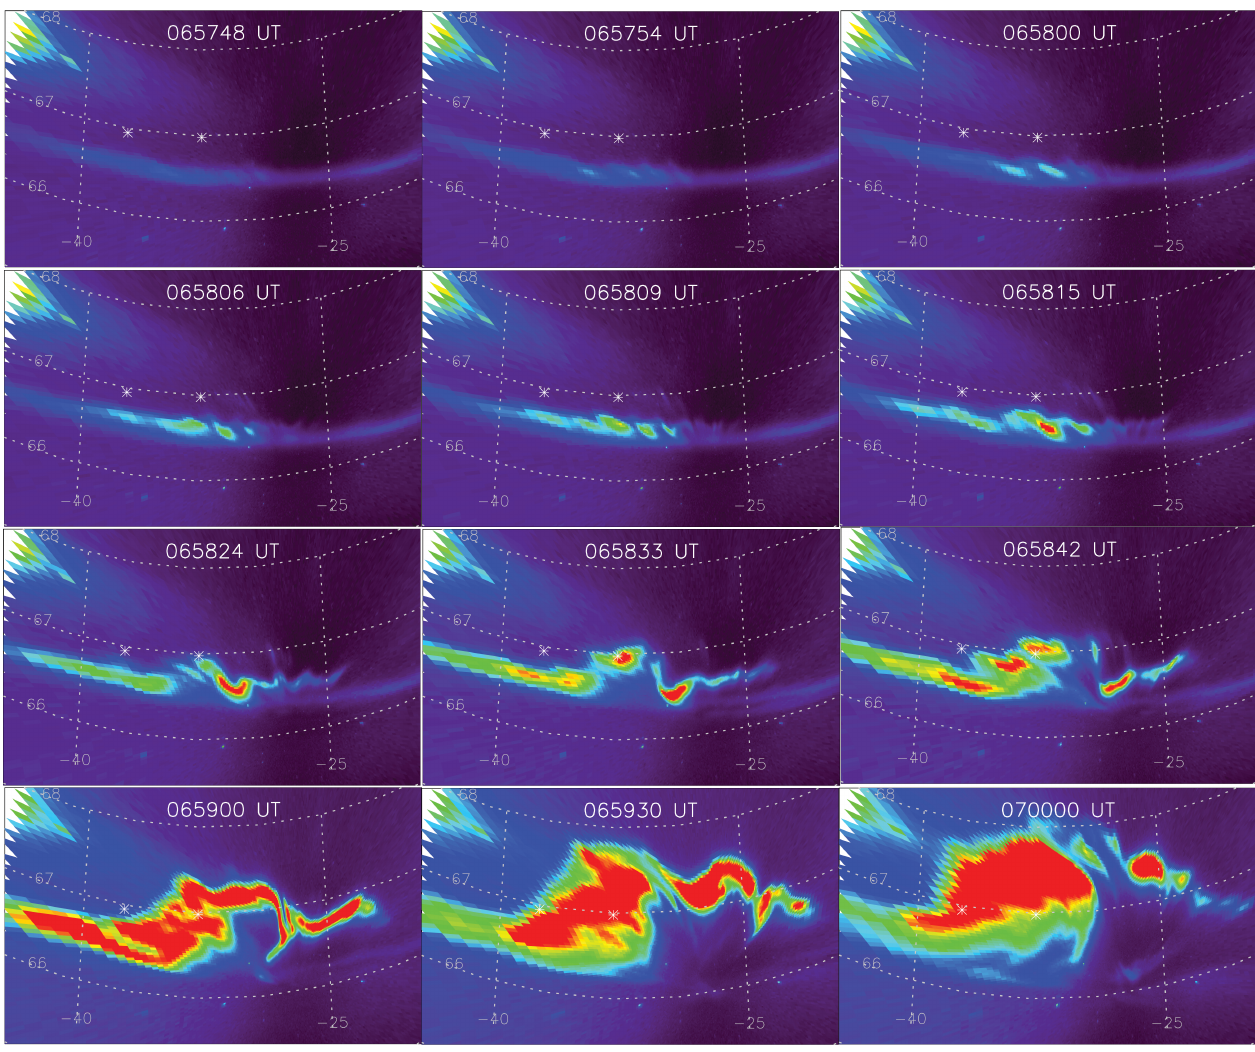
Fig. 5. A series of auroral images showing the auroral breakup and expansion. The footprints of TH-D (eastern one) and TH-E are labeled in